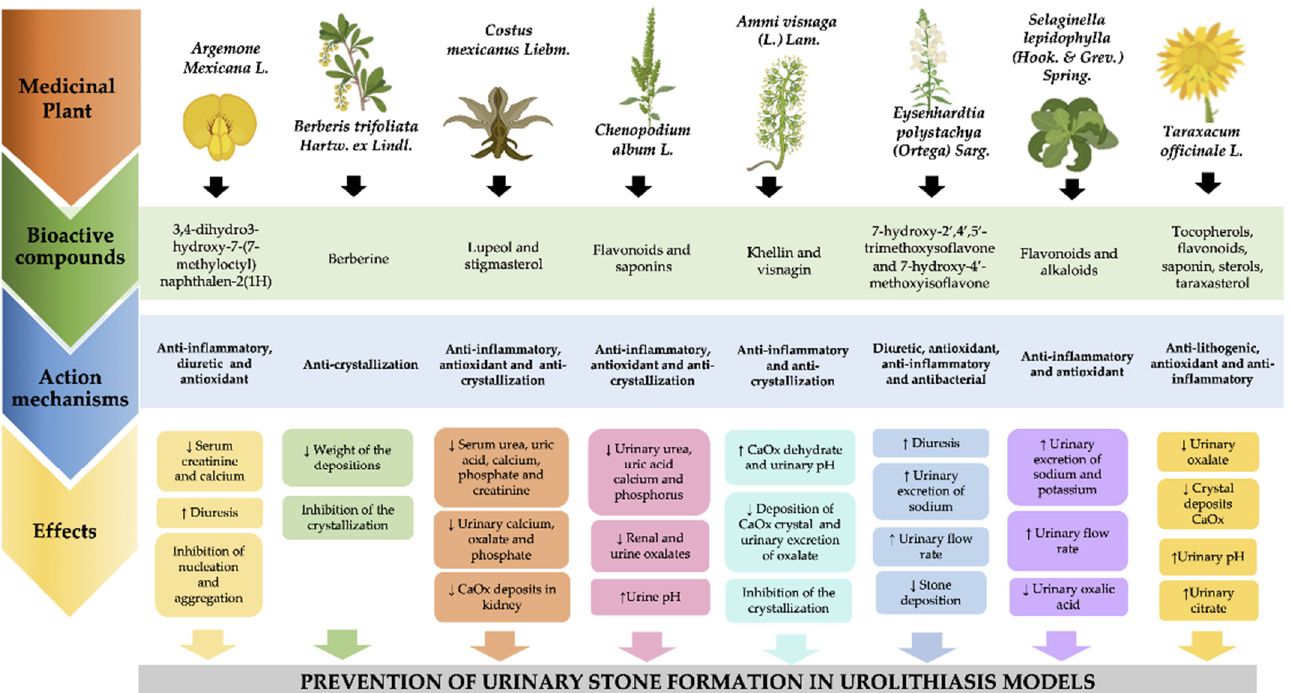
Figure 2. Molecular mechanisms involved in beneficial effects of medicinal plants through their bioactive compounds. CaOx: Oxalate calcium.